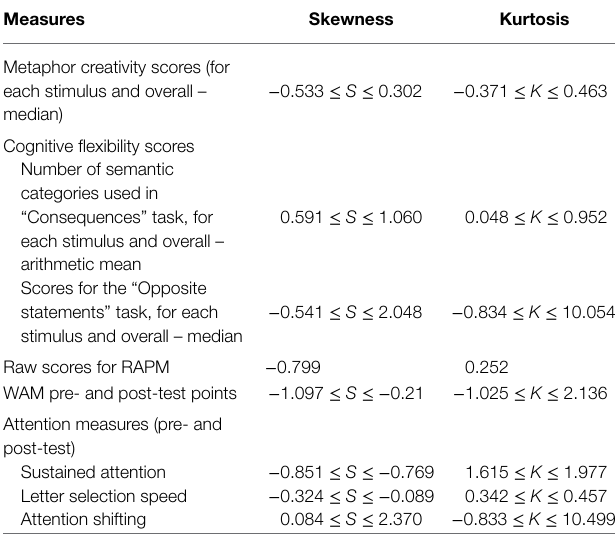
TABLE 2 | Overview and brief description of the main measures used in this study (with skewness and kurtosis estimates). Measures Skewness Kurtosis